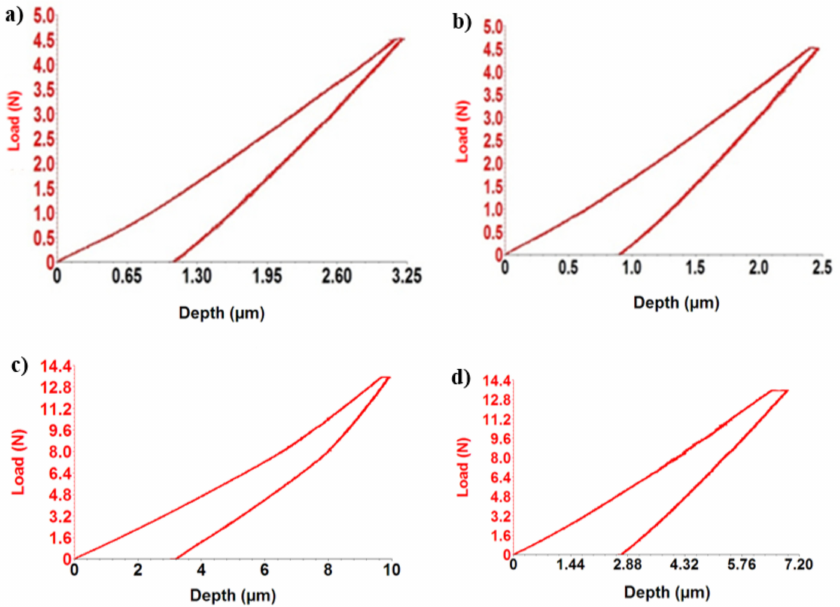
Figure 3. The strength-depth curve of the indentation test for Ti-based alloys developed: ( a ) Ti 15 Mo 7 Zr 5 Ta, ( b ) Ti 15 Mo 7 Zr 15 Ta, ( c ) Ti 15 Mo 0.5 Si, and ( d ) Ti 15 Mo 1